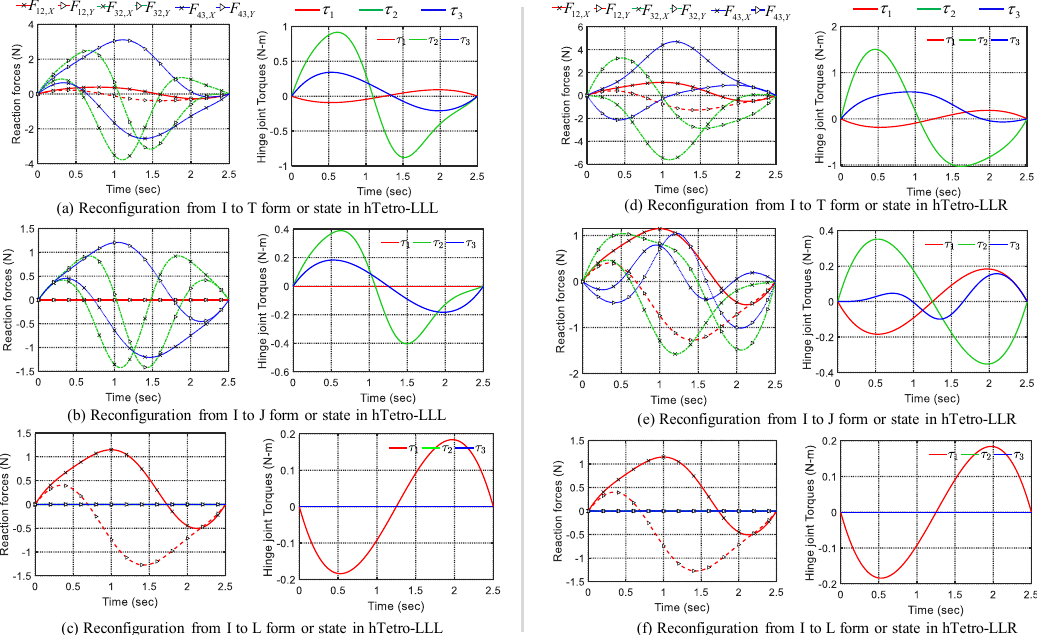
Figure 8. Joint reaction forces components and the joint torque at each of the three hinge joints during reconfiguration. Detailed results with video in simulation are presented in